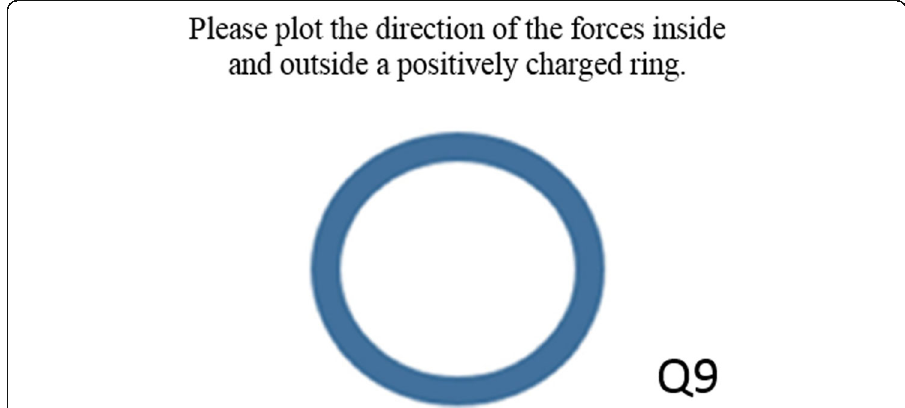
Fig. 7 Question about the direction of the forces for a positively charged ring. Q9 Source: Question developed by the researchers